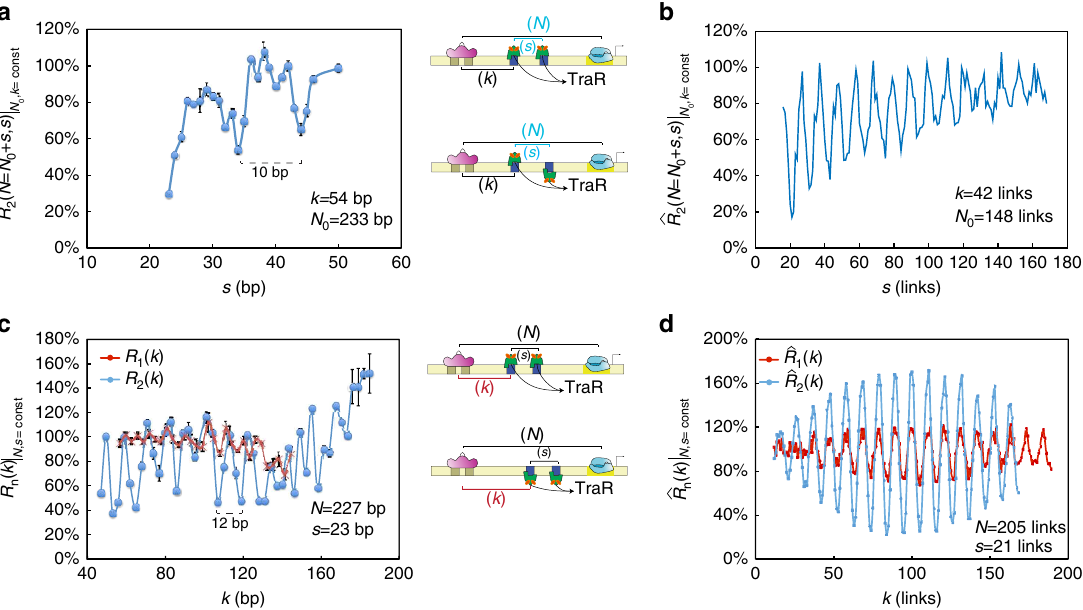
Figure 3 | Excluded volume is additive. ( a ) Expression level ratio for synthetic enhancers with a tandem of TraR-binding sites at various inter-TF spacing ( s ) and looping lengths ( N ); see schematic on the right. ( b ) Model predictions for looping probability ratio as a function of intra-binding site spacing s and looping length N . ( c ) Expression level ratio measurements for synthetic enhancers with a tandem of TraR-binding sites (blue) that are in-phase with fixed inter-TF spacing ( s ¼ 23bp); see schematic on the right. The single TraR-binding site synthetic enhancer data are overlayed as reference in red. ( d ) Model predictions for looping probability ratio as a function of distance to the chain origin ( k ) for the following configurations: blue, in phase tandem protrusions ( s ¼ 21bp); red, single protrusion. Error bars correspond to the s.d. from multiple